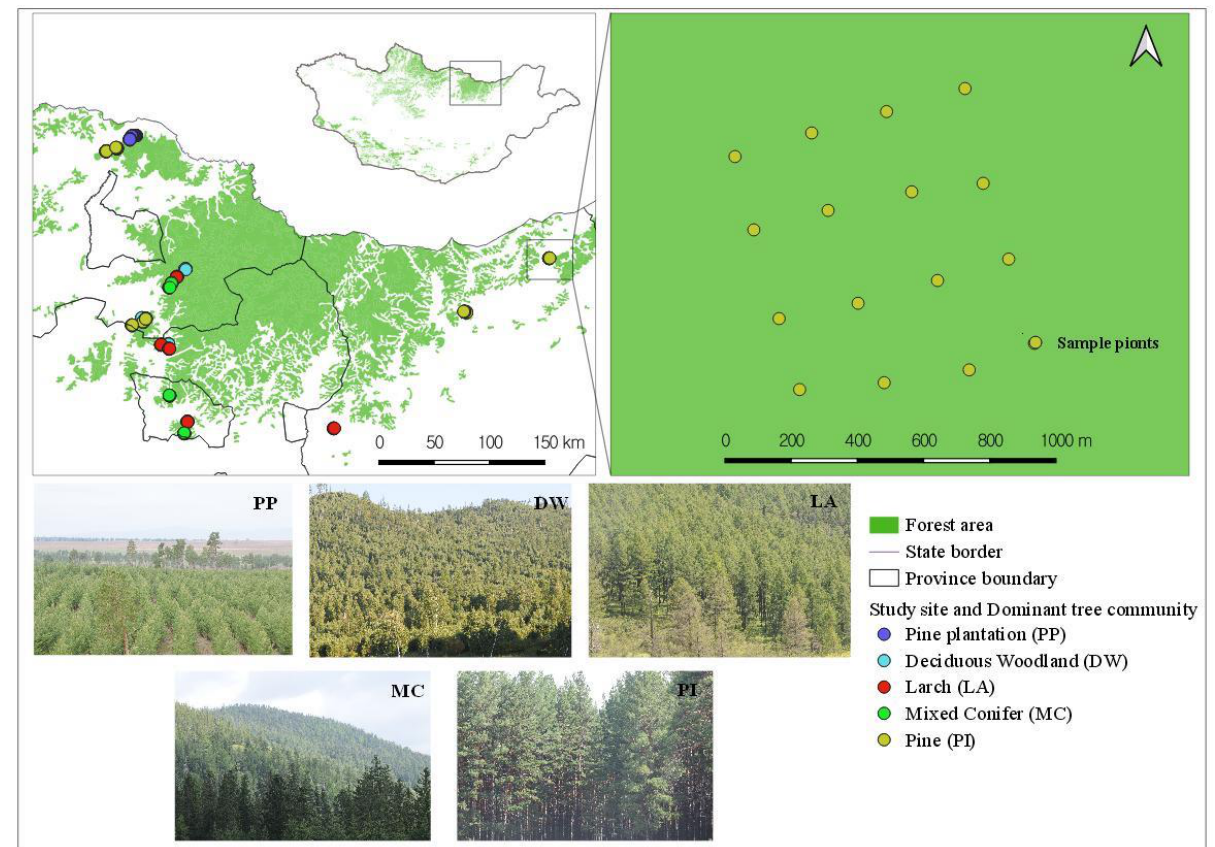
Figure 1. Study area location and sampling sites in a forested area of the Khentii Mountains.